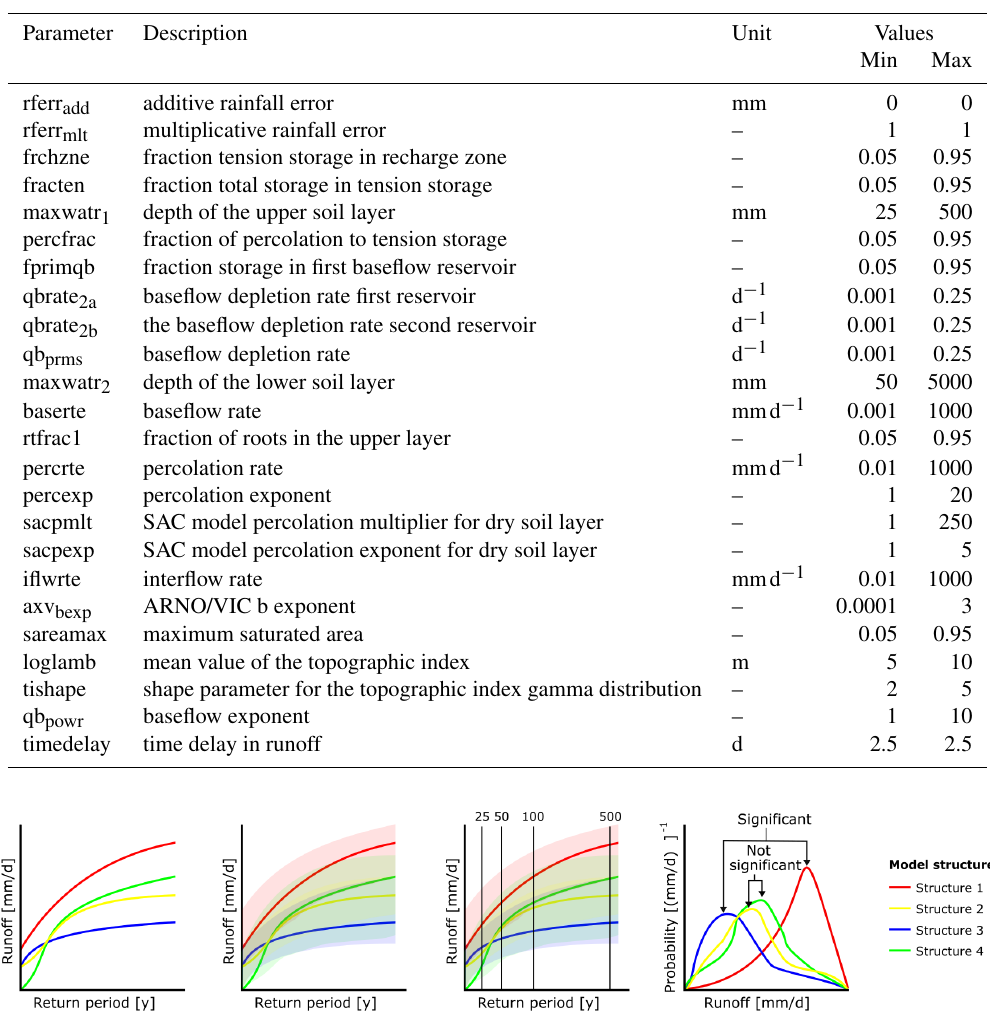
Table 2. Description and range of the parameters that were sampled, based on Vitolo et al. (2015)